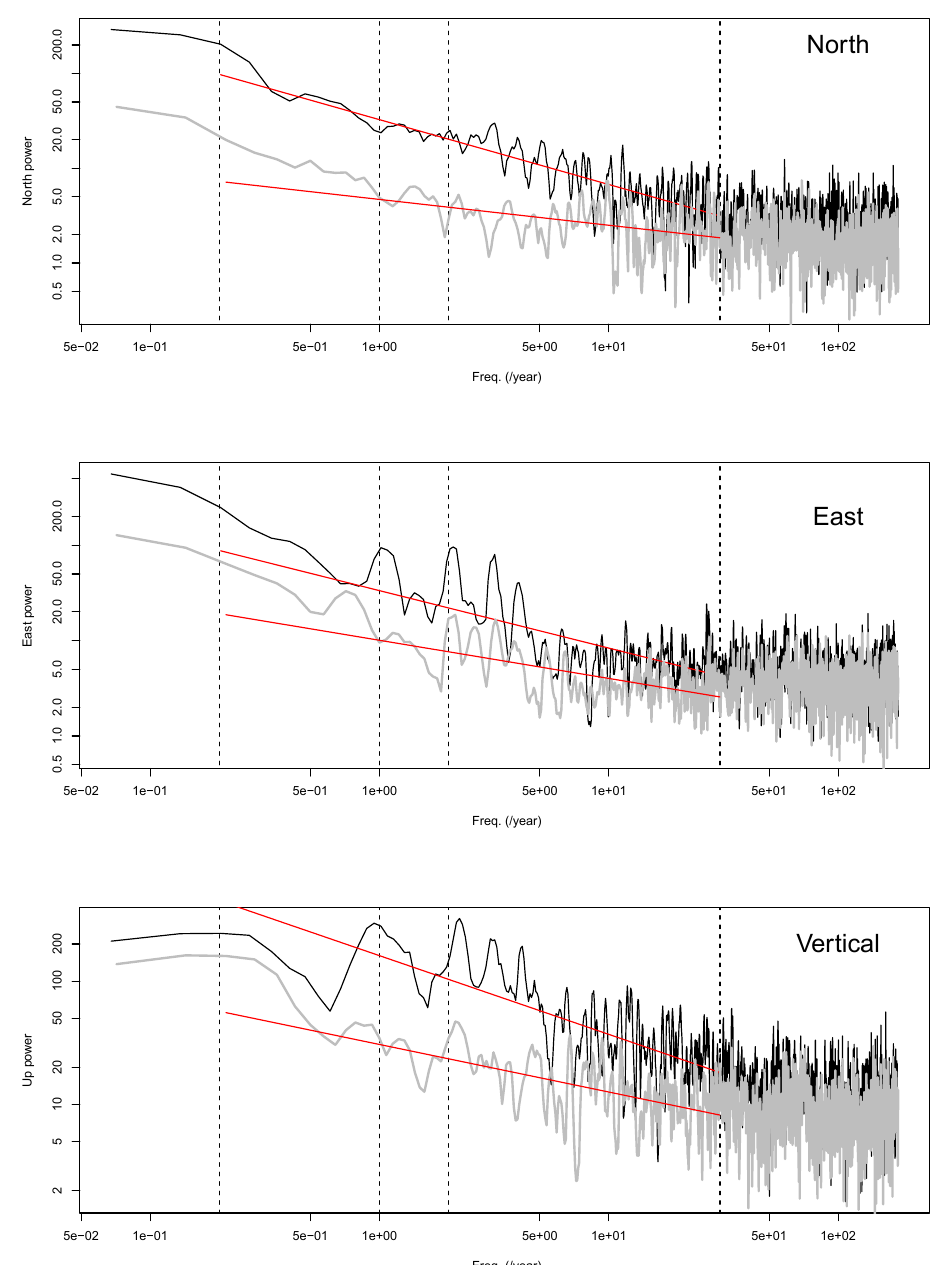
Figure 5. Noise spectra for site MTPL. Spectra derived form the unfiltered time series are in black, those for the filtered time series are in grey. The red lines represent the best spectral models used for the uncertainty analyses.